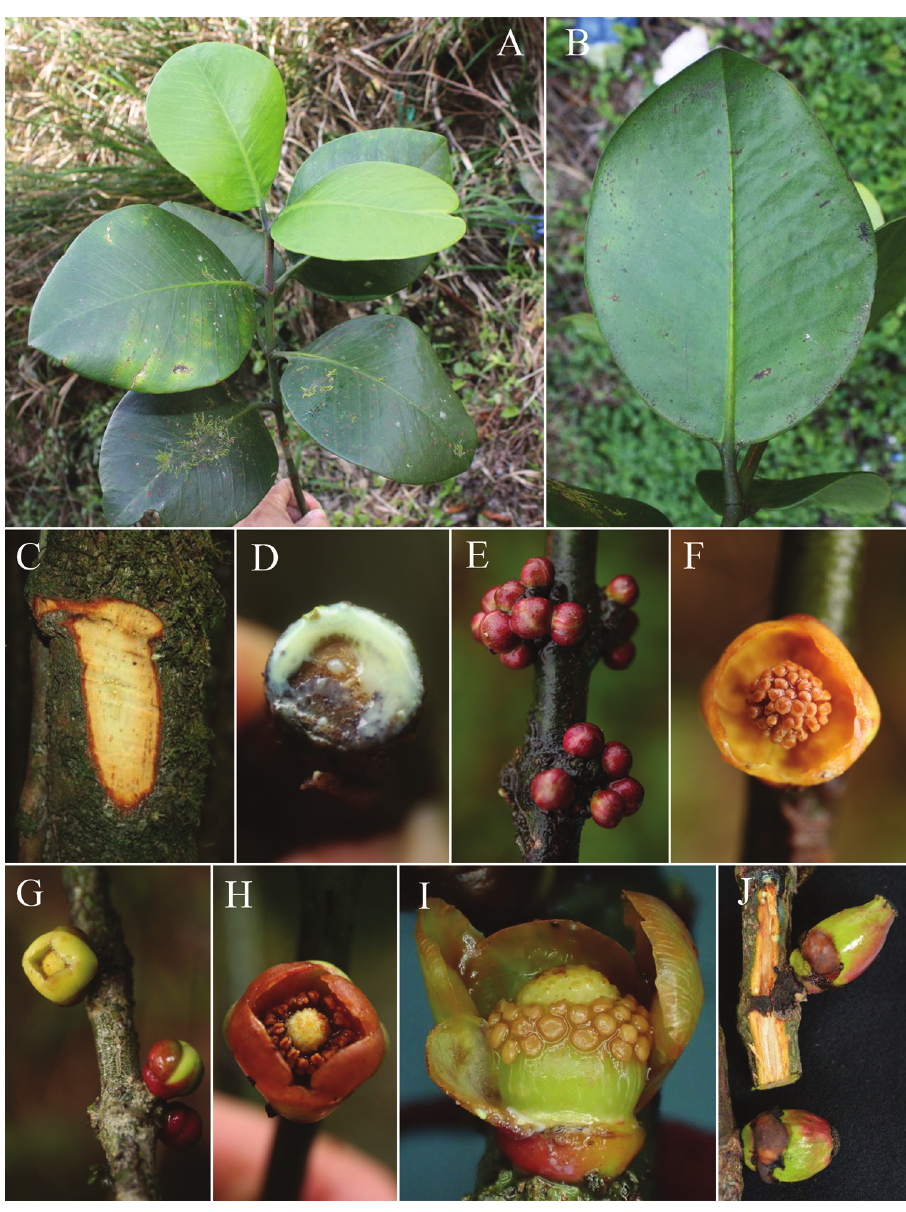
Figure 2. Garcinia hopii H.Toyama & V.S.Dang sp. nov. A branch with leaves B abaxial surface of leaf C trunk D latex E staminate flower buds F staminate flower G pistillate flower and buds H pistillate flower I pistillate flower, some tepals removed J immature fruits. A – C photographed on 22 January 2015 E photographed on 19 November 2014 D, F – I photographed on 27 February 2016, J photographed on 24 April